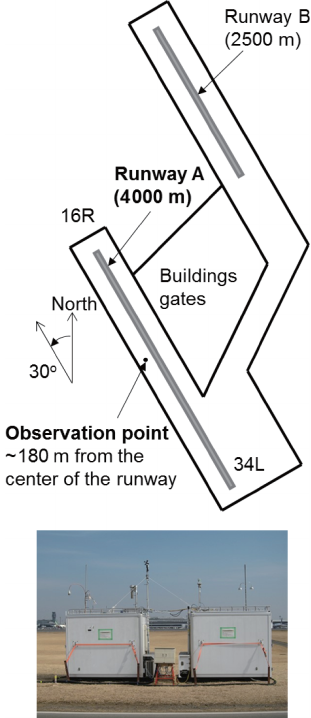
Figure 1. Approximate layout of Narita International Airport (NRT). The observation point was located ∼ 180m from the cen- terline of runway A ( ∼ 140m from the edge of the runway). The azimuth of runway A is 30 ◦ from the north (23 ◦ from the mag- netic north). The photograph shows the containers of instruments deployed at the observation